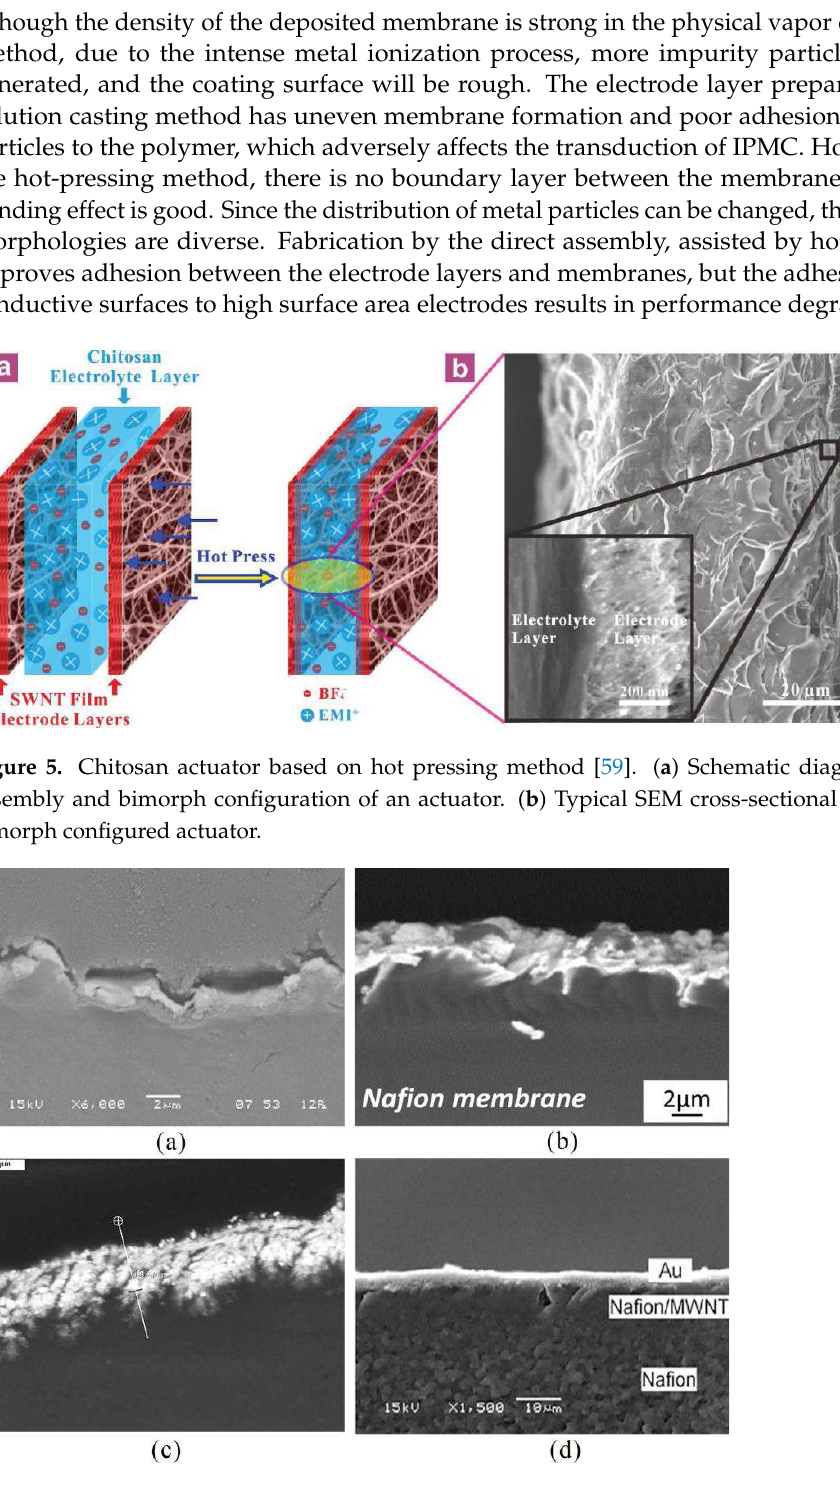
Figure 6. Cross-sectional morphology of IPMC prepared by different physical plating methods. ( a )